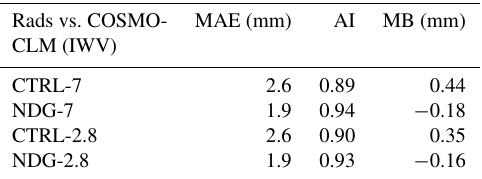
Table 1. Mean absolute error (MAE), agreement index (AI) and mean bias (MB) of IWV between the model and the observations. The selected observations are all radiosondes available in the pe- riod 26 October at 00:00UTC to 28 October at 00:00UTC at the seven stations within the 2.8km simulation domain (see red box in Fig. 1). All model values have been interpolated to the location of the radiosonde station from the nearest neighbours. The difference between the model and the station height never exceeded